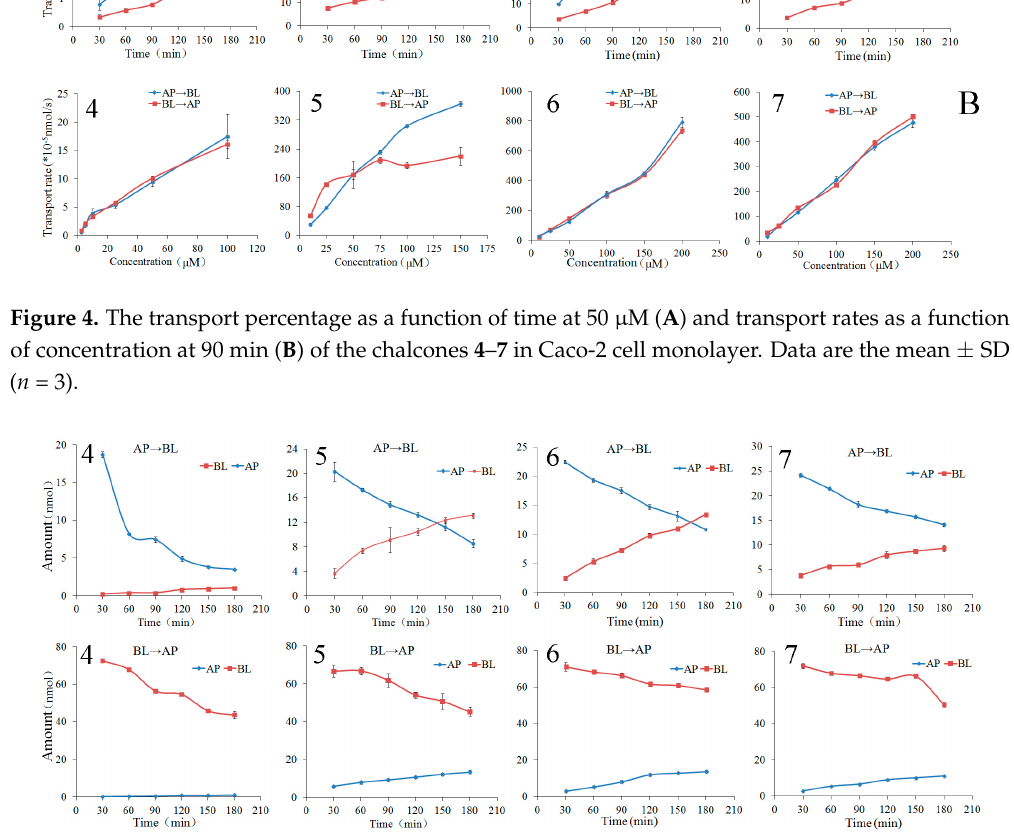
Figure 5. Transport kinetics curves of the chalcones 4 – 7 in Caco-2 monolayer from apical to basolateral direction at 50 µM. Data are the mean ± S.D ( n = 3).